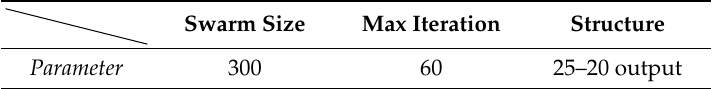
Table 4. Characteristics and parameters of the optimized ANN-based particle swarm optimization (PSO).